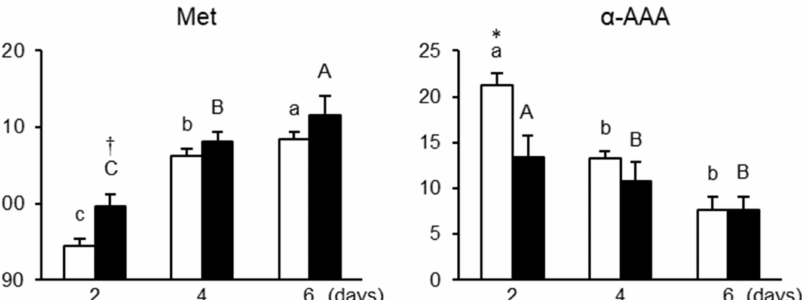
Figure 6. Concentrations of the molecular species that showed differences between the low and high activation groups in culture media. a–c: Different letters indicate significant differences between different cultural periods in the low activation group ( p < 0.05). A–C: Different letters indicate significant differences between different cultural periods in the high activation group ( p < 0.05). * An asterisk indicates a significant difference between the low and high activation groups ( p < 0.05). † A dagger indicates a tendency in the difference between the low and high activation groups ( p < 0.1). Numbers in parentheses indicate the number of the strip in each group. Error bars indicate SEM.